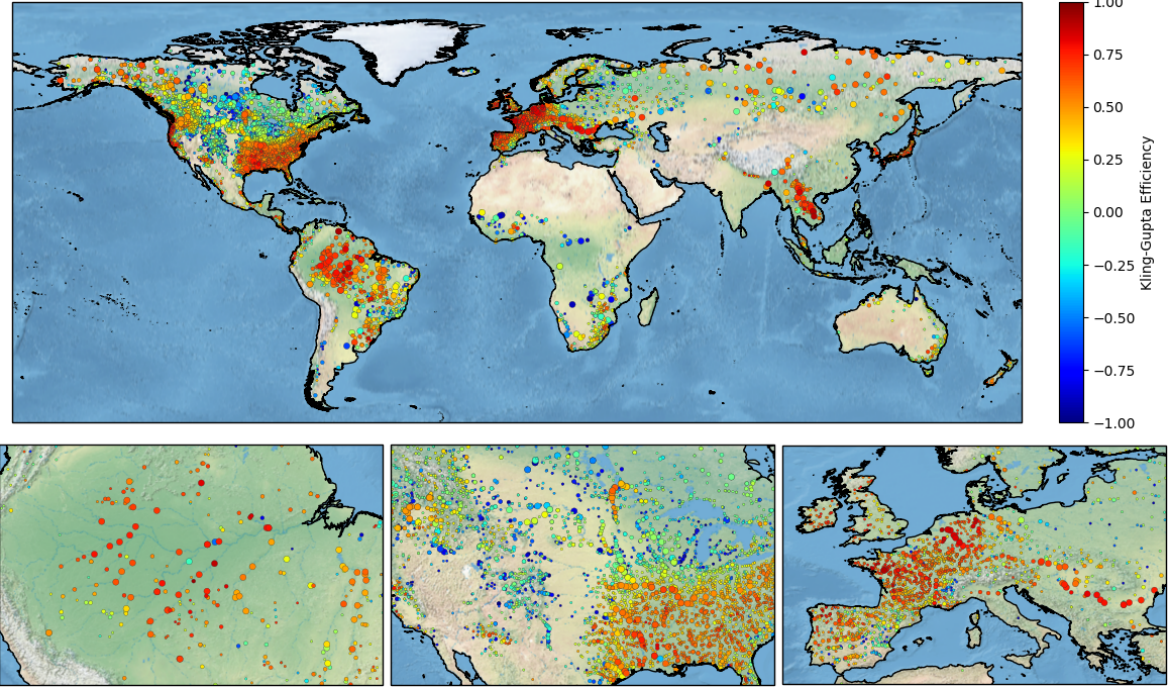
Figure 15. Kling–Gupta efficiency for CTRIP-12D over 11238 gauge stations (with KGE > − 1), and zooms over the Amazon basin, North America and Europe. The circle size depends on the drainage area at the station.